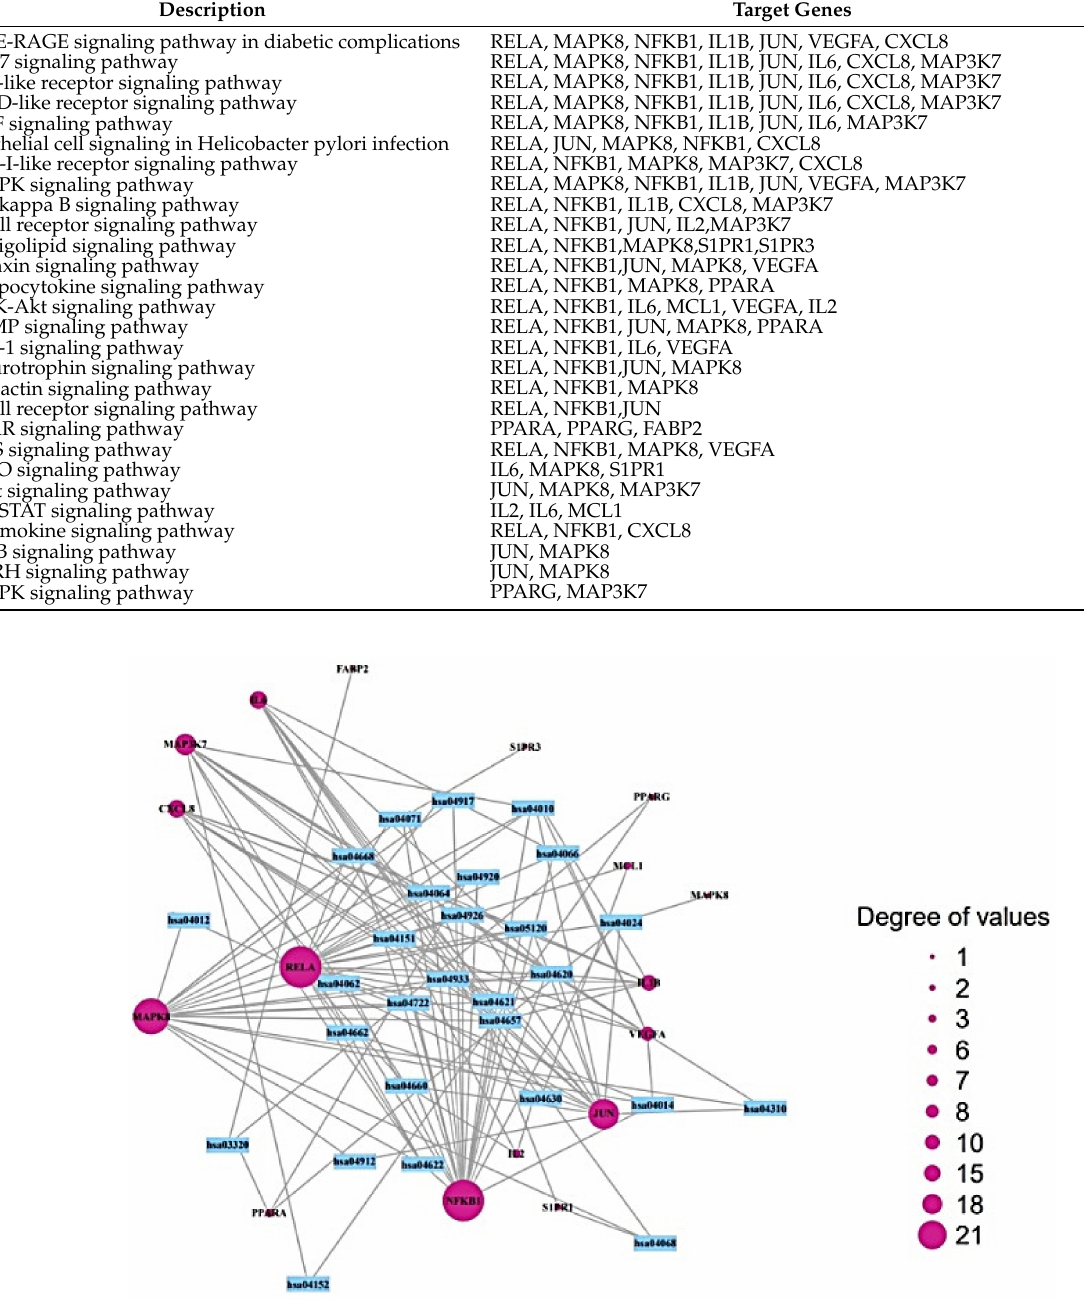
Figure 6. Degree values of 17 genes in 28 signaling